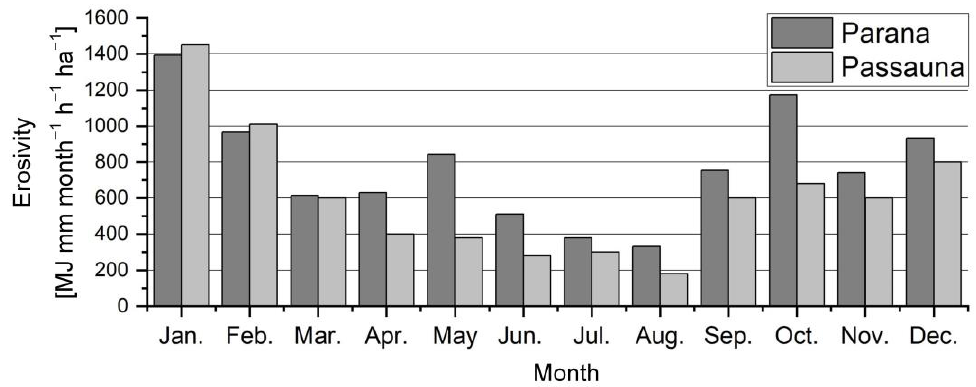
Figure 4. Erosivity in Passa ú na and Paran á after [26]. Figure 3. Erosivity in Passaúna and Paraná after [26].